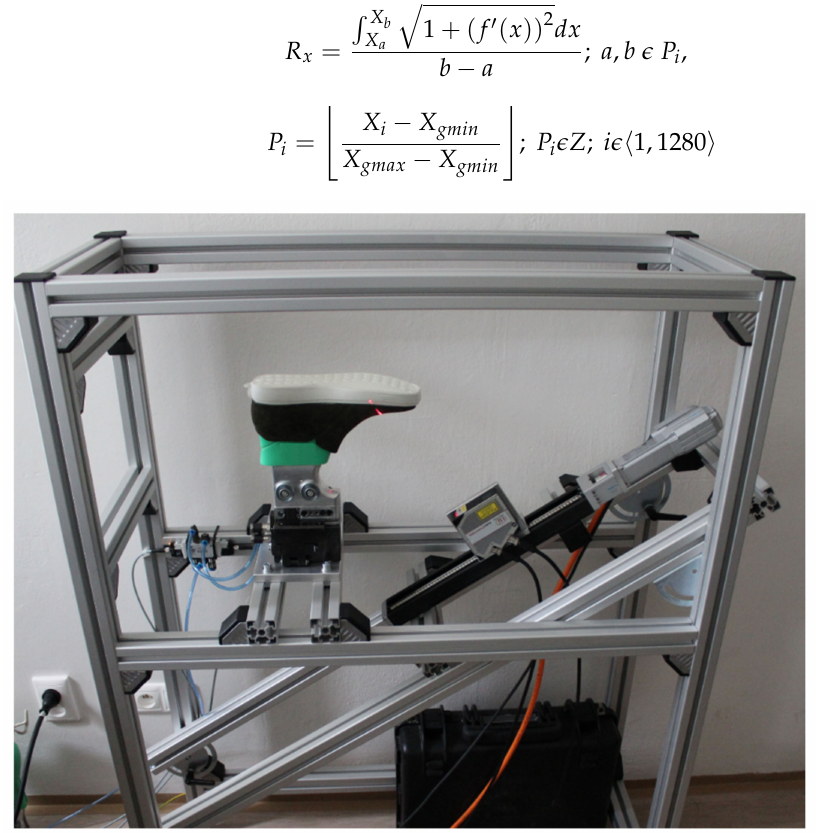
Figure 10. Experimental stand in